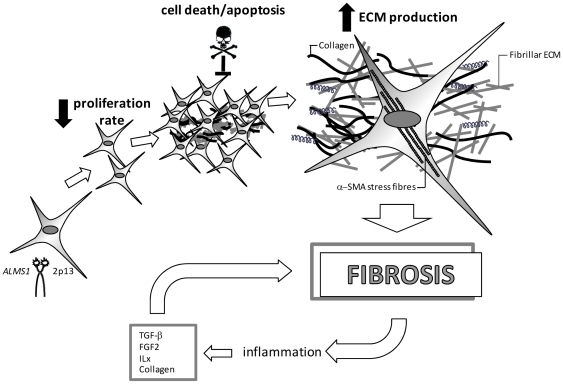
Model of fibrosis in Alström Syndrome.Fibroblasts carrying ALMS1 mutations display an elongated shape, proliferate slowly, but are still responsive to pro-fibrotic factors and resistant to cell-death stimuli, suggesting that their proliferation is not controlled by apoptosis. ALMS1 mutated fibroblasts persist, continue to proliferate and to synthesize and secrete high levels of ECM, responsible for progressively remodeling and destroying normal tissue architecture, resulting in fibrosis. The microenvironment could be characterized by an excess of mediators enhancing a cellular pro-fibrotic phenotype, that together with inflammatory reactions could stimulate the fibrosis in an autocrine loop.